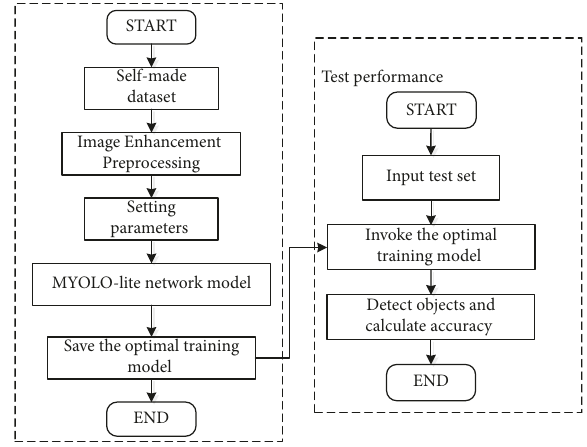
Figure 5: Flowchart of object detection algorithm based on MYOLO-lite